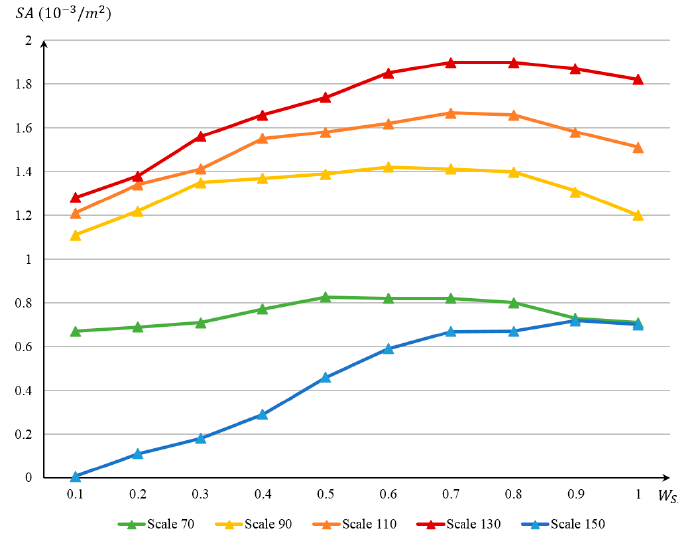
Figure 14. The dynamics of changes in segmentation accuracy ( (cid:1845)(cid:1827) ) with increasing (cid:1849) (cid:3020)(cid:3017) at five scales.